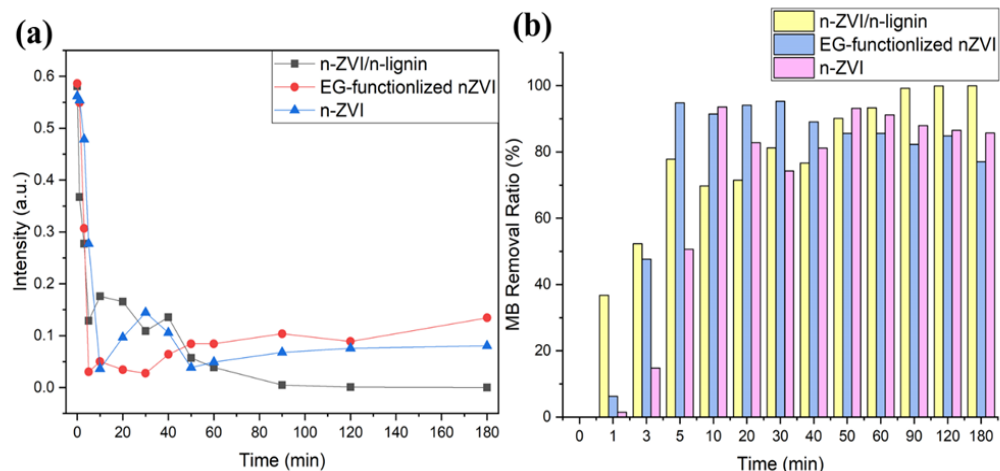
Figure 9. ( a ) UV – Vis absorption intensity at the wavelength of 664 nm for bare nZVI, EG-functionalized nZVI, and nZVI/n-lignin. ( b ) The removal ratio of methylene blue for bare nZVI, EG-functionalized nZVI, and nZVI/n-lignin.